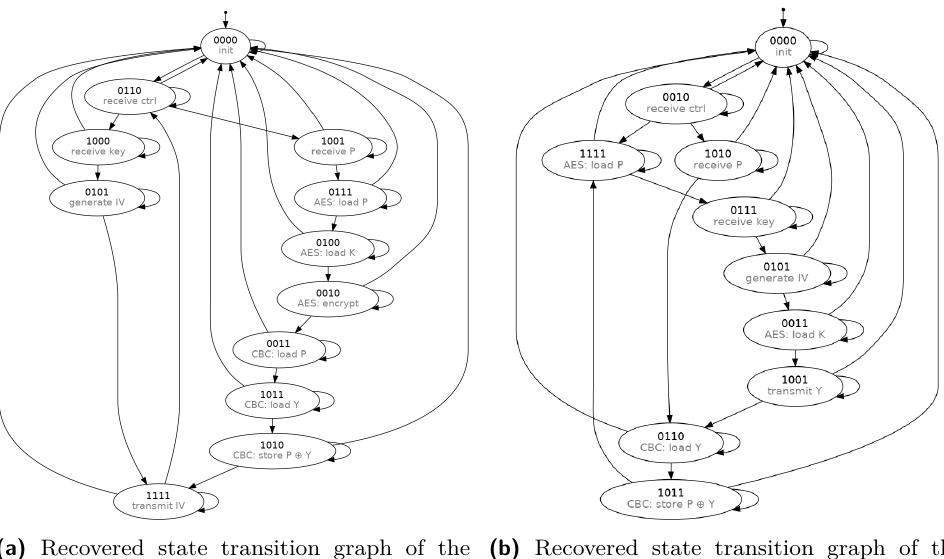
Figure 5: Recovered state transition graphs using the algorithm from [FWD + 18]. Note that the analyst does not know the semantic meanings marked in